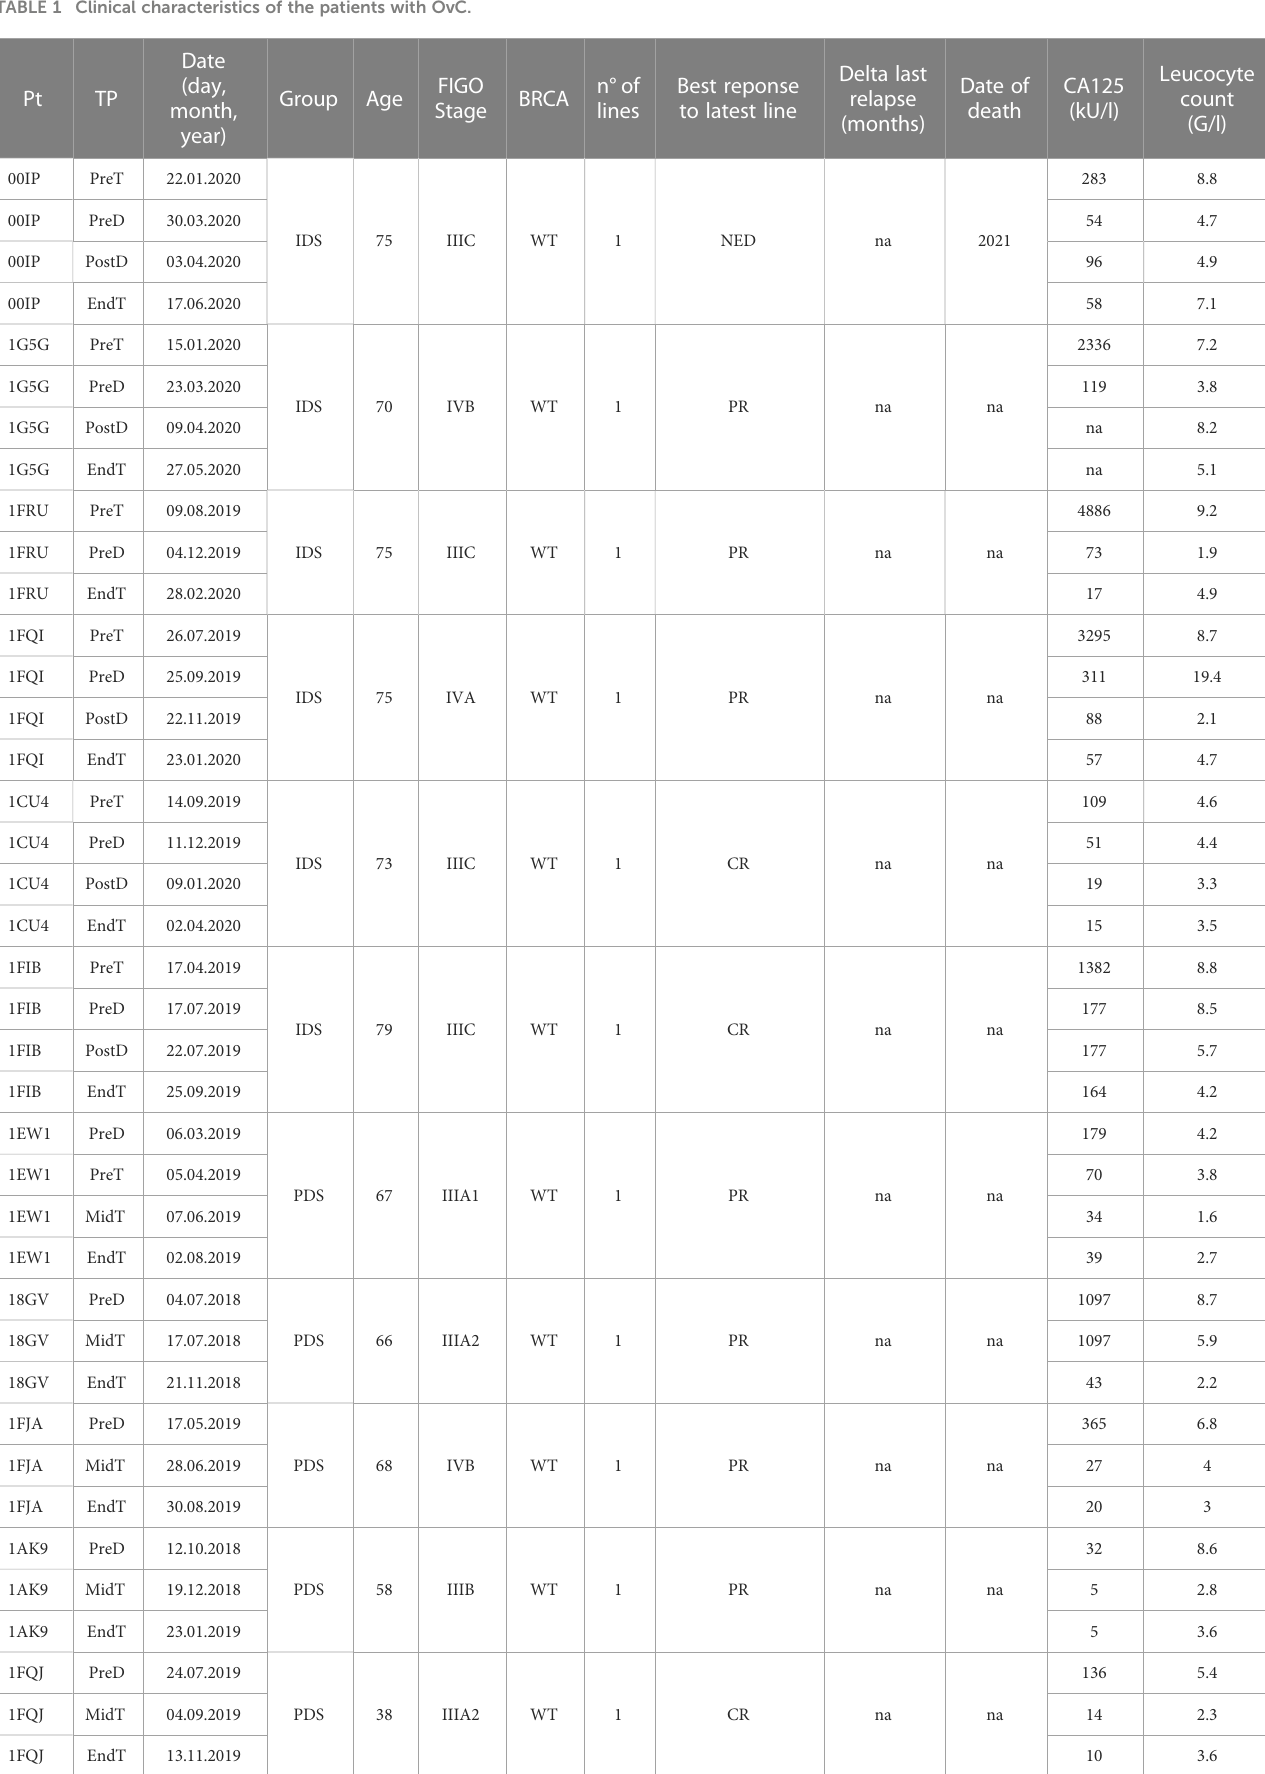
TABLE 1 Clinical characteristics of the patients with OvC.